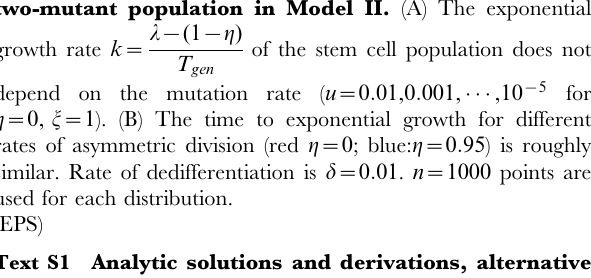
shown as a box-whiskers plot. All mutant cells are allowed to dedifferentiate with probability of dedifferentiation give by Eq.